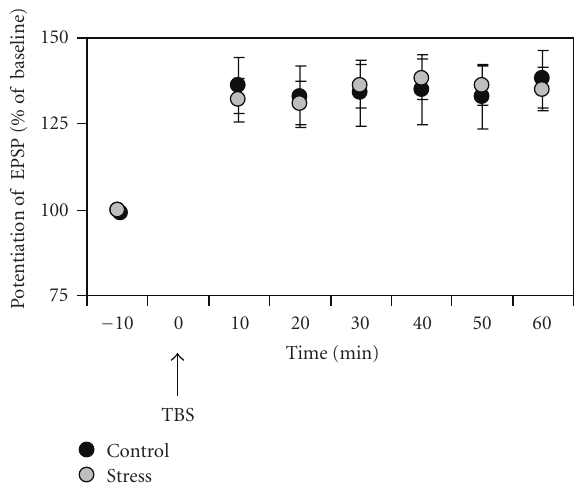
Figure 4: TBS-induced potentiation in control and stress rats . Both control ( n = 14) and stress ( n = 11) rats have shown an increase in the slope of the EPSP. The magnitude of the EPSP potentiation was not significantly di ff erent between the two